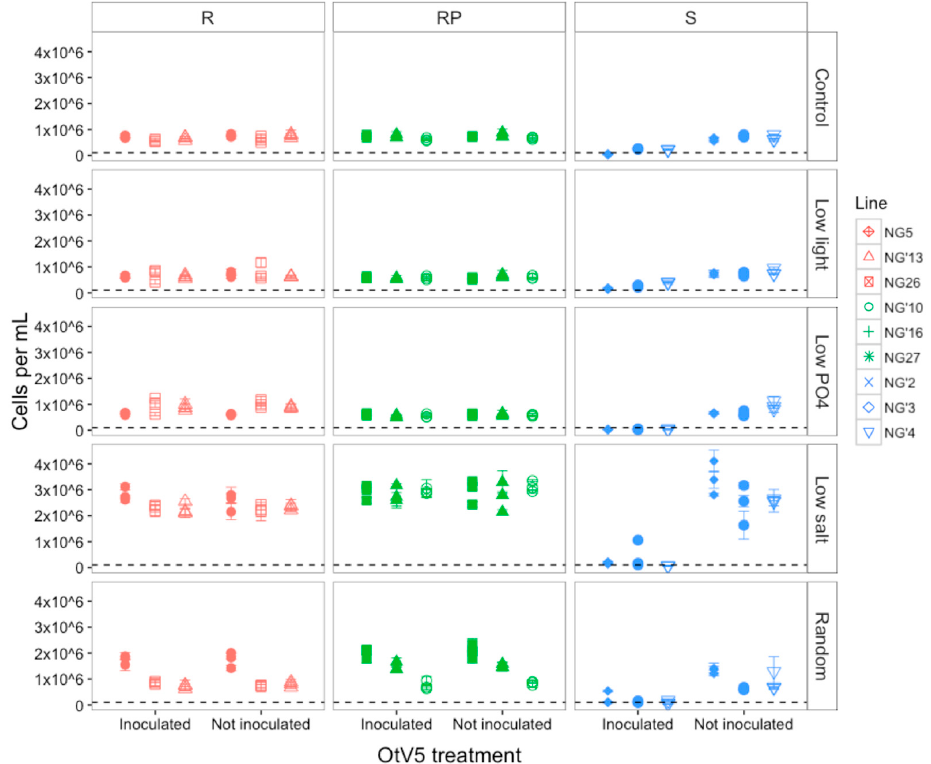
Figure 1. Mean ( ± SE) cell density mL − 1 of resistant (R), resistant producer (RP) and susceptible (S) O. tauri lines three days after OtV5 inoculation in five environments. Points represent the average of the three assay replicates for each evolved population. Inoculated = populations inoculated with OtV5, Not inoculated = negative control populations that were grown for the same period without OtV5 inoculation. There were three evolved populations of each line. The dashed line represents the starting cell density at 100,000 cell mL − 1 .